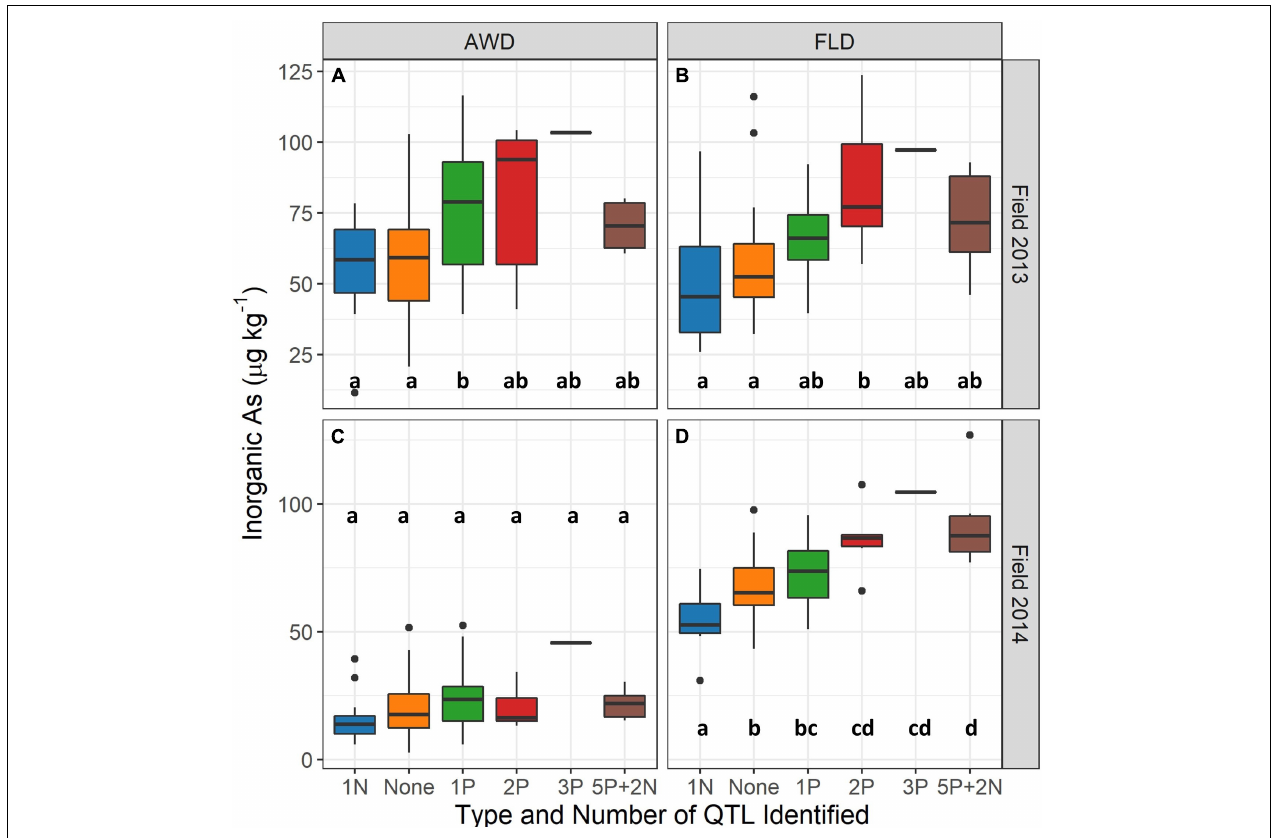
FIGURE 3 | Brown rice inorganic As concentrations ( µ g kg - 1 ) in field 2013 under alternate wetting and drying (AWD) (A) and flooded (FLD) (B) and 2014 AWD (C) and flood (D) irrigation management treatments by number of quantitative trait loci (QTLs) in eight TILs and two parents. Safe-AWD was used in 2013, and AWD30 was used in 2014. Only one biological replication of the genotype containing three positive iAs affecting QTLs was grown in 2013 and 2014; all other QTL groups have a minimum of six biological replicates. Letters indicate significant differences within each treatment and year ( p < 0.05).